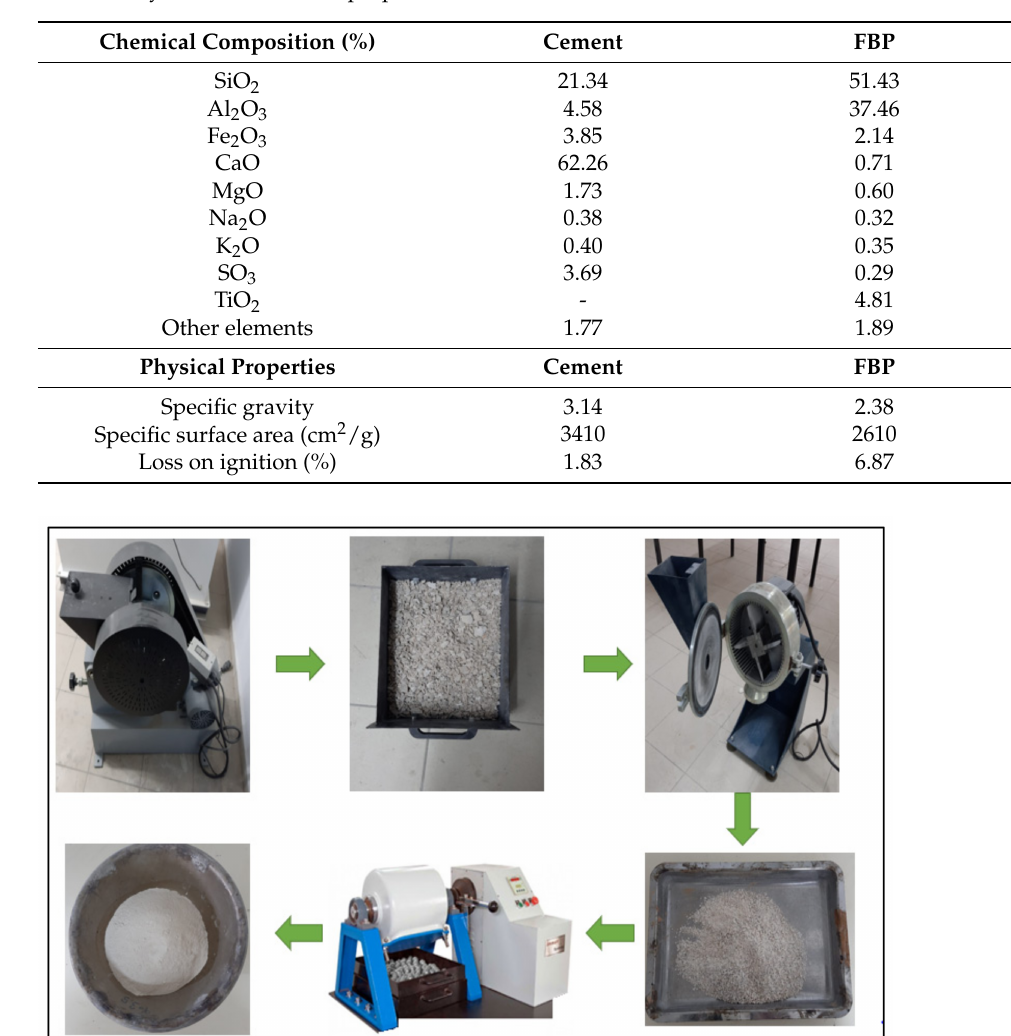
Figure 1. Production stages of firebrick powder.